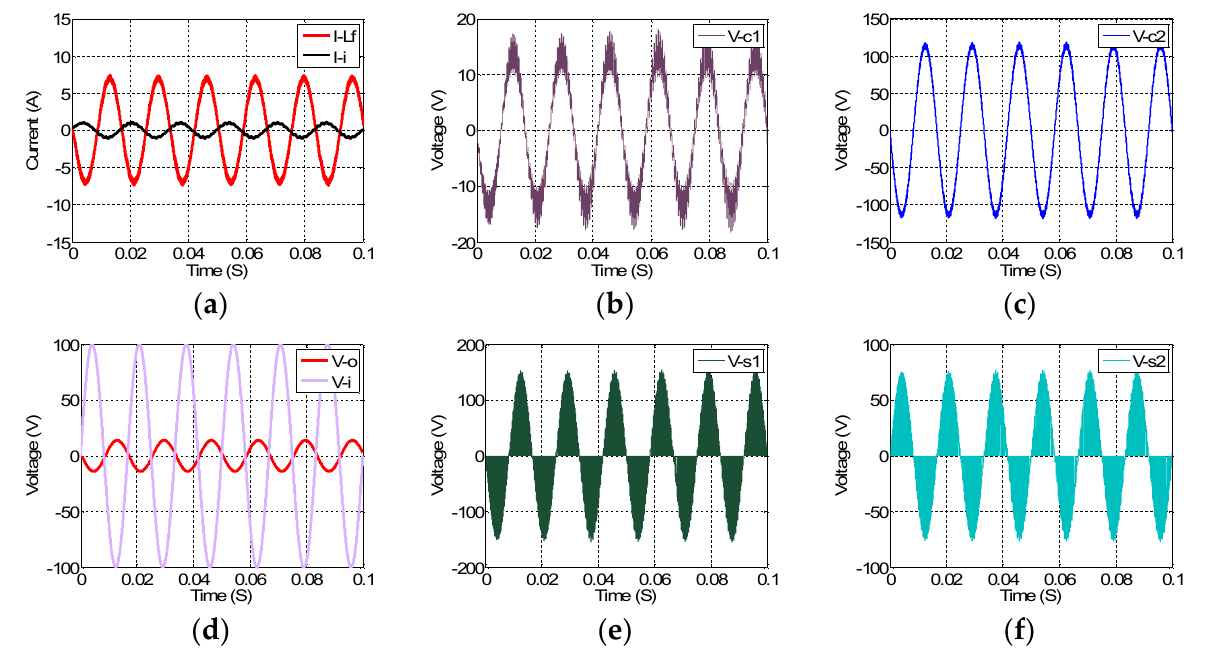
Figure 14. Simulation results of the buck out-of-phase mode with n = 2, R = 2 Ω and D = 0.8. ( a ) output filter and input current; ( b ) Voltage across C 1 ; ( c ) voltage across C 2 ; ( d ) output and input voltages; ( e ) voltage across S 1 ; ( f ) voltage across S 2. Figures 15 and 16 show the simulation results of the presented dynamic voltage re- storer based on the proposed converter with n = 1.5. A proportional integral (PI) control- ler has been utilized to adjust the load voltage. Figure 15a depicts the line voltage with an RMS value of 220 V when 60% voltage sag occurs at 0.25 s to 0.35 s. It is seen that the